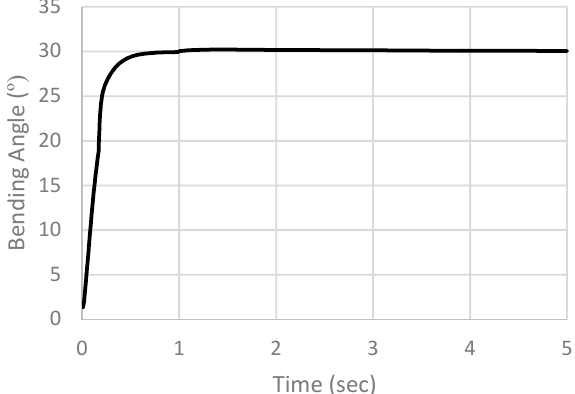
Figure 26. Simulation results with concentrated force added at the tip of the actuator.